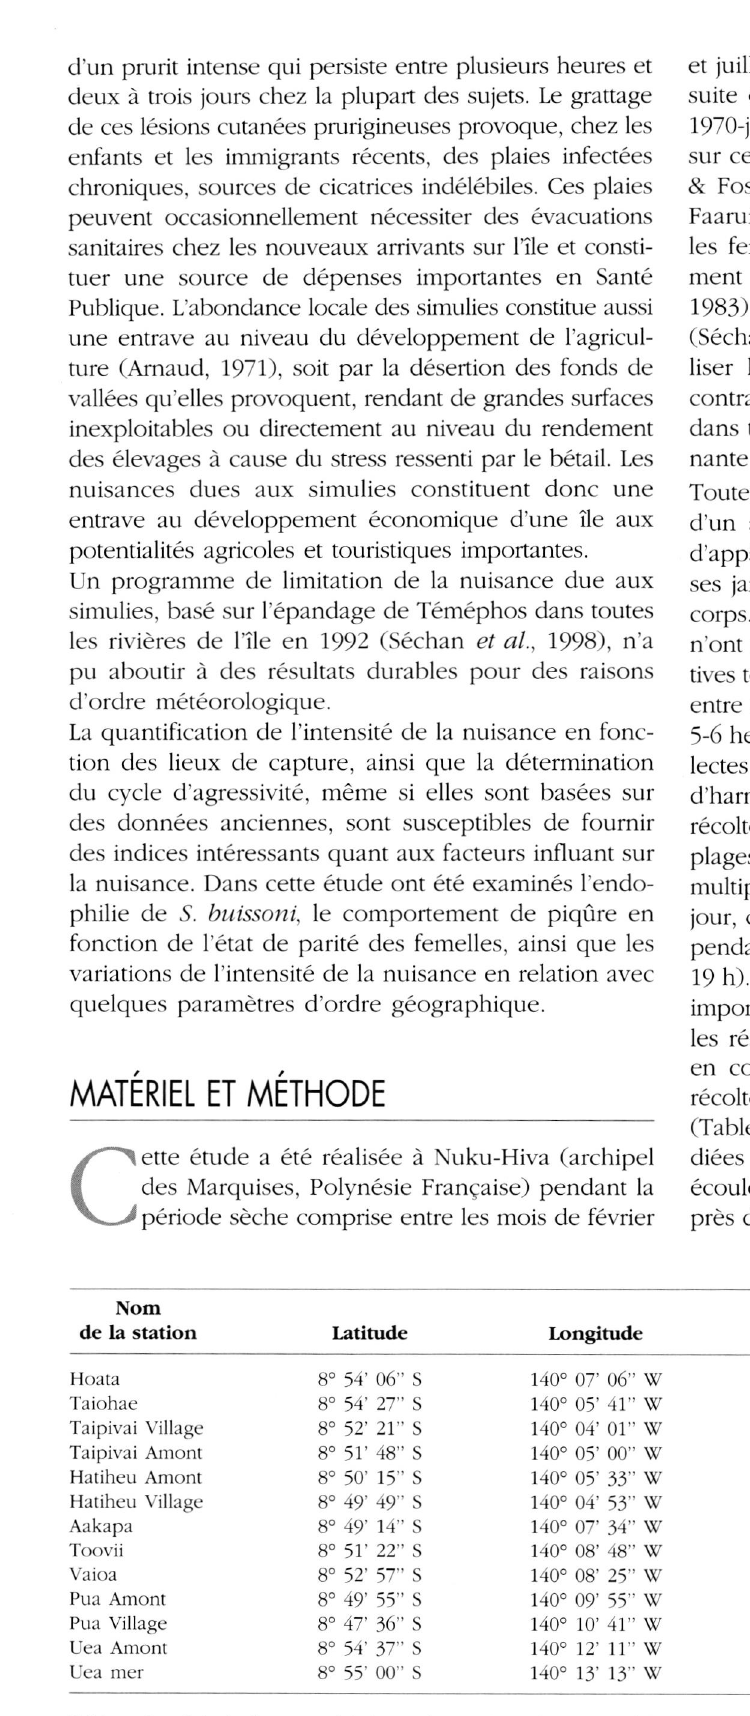
Tableau I. - Principales caractéristiques des stations de capture fréquentées sur l'île de Nuku-Hiva en 1972.